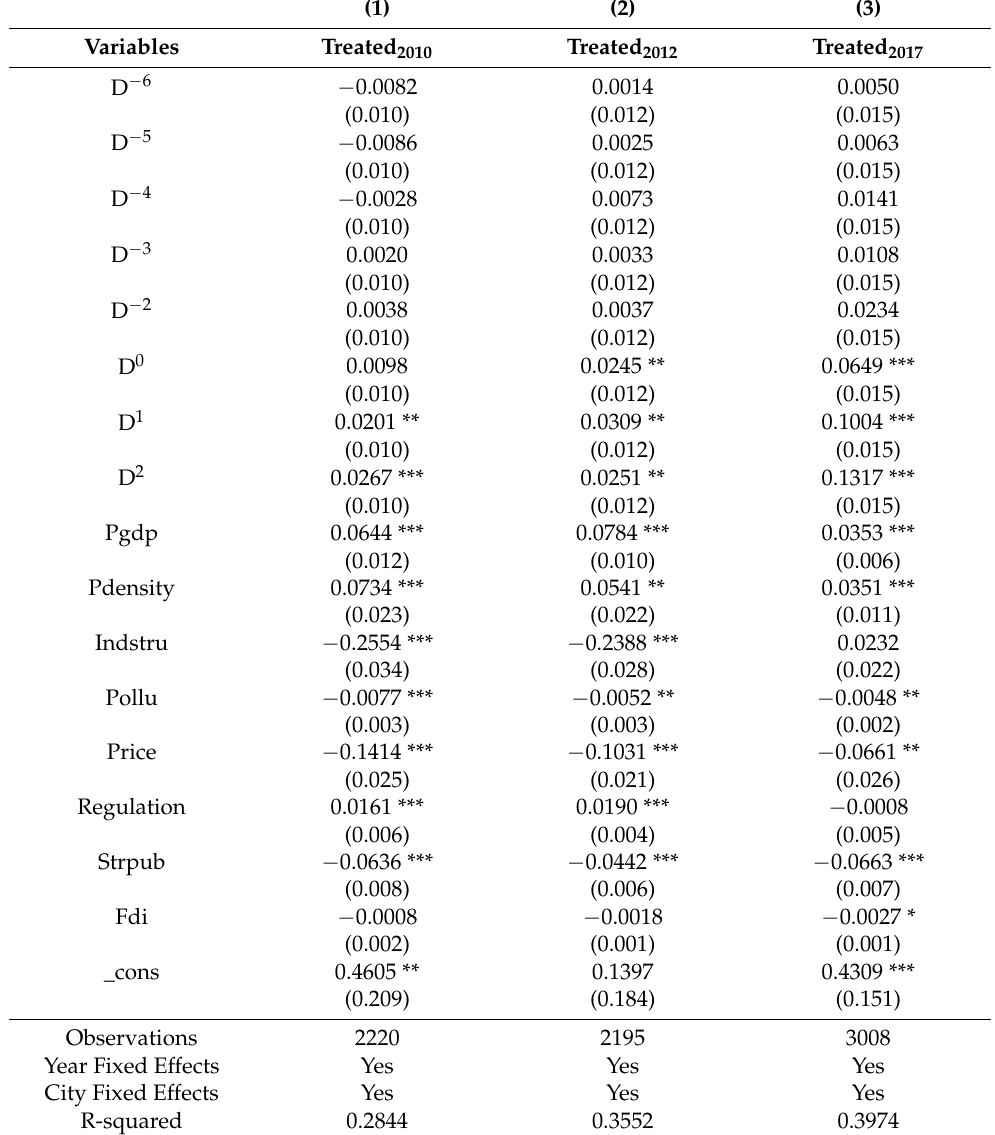
Table 6. Parallel trend test of three